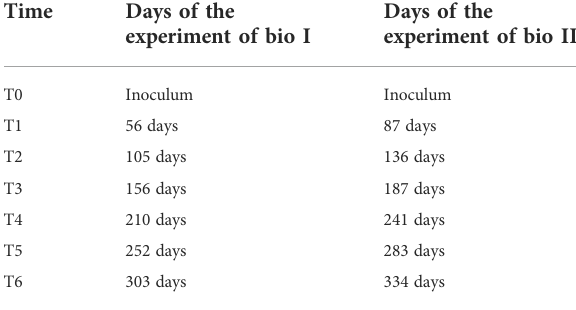
TABLE 1 Sampling days for microbial diversity